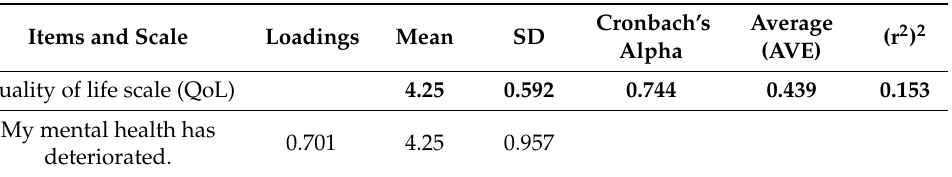
Table 1. Results for Principal Components Analysis, reliability, and internal consistency, and descrip- tive statistical values of the COV19-QoL scale. Items and Scale Loadings Mean SD Quality of life scale